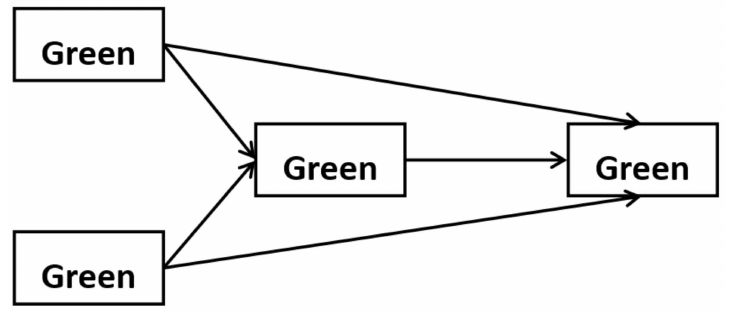
Figure 1. Research